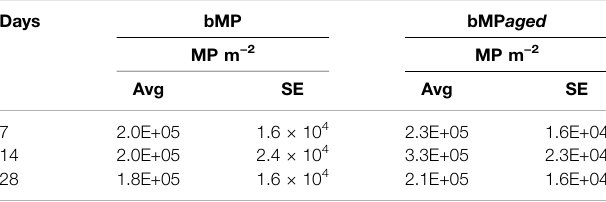
bMP/bMP aged were quanti fi ed by counting using light microscopy. Represented are mean values of fi ve biological replicates and the standard error of the mean (SE). Statistical differences between absolute abundances among time points were tested using ANOVA in